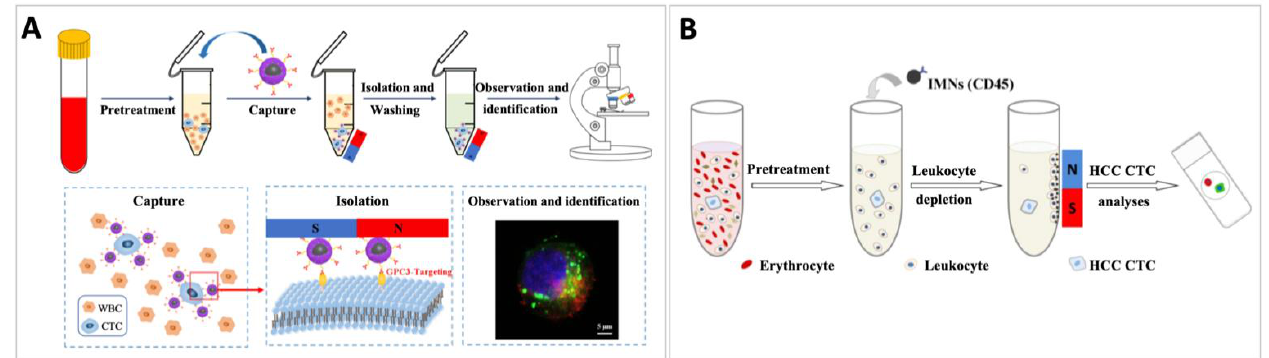
Figure 4. Positive vs negative selection strategies. ( A ) Positive selection of circulating hepatocellular carcinoma cells (HCC) from blood using nanoparticles targeting GPC3 antigen. Reproduced with permission from [92]. Copyright © 2021 Chu et al. ( B ) Negative selection strategy for efficient isolation of HCC using anti-CD45 antibody-modified magnetic nanospheres. Adapted with permission from [93]. Copyright 2016 Elsevier.